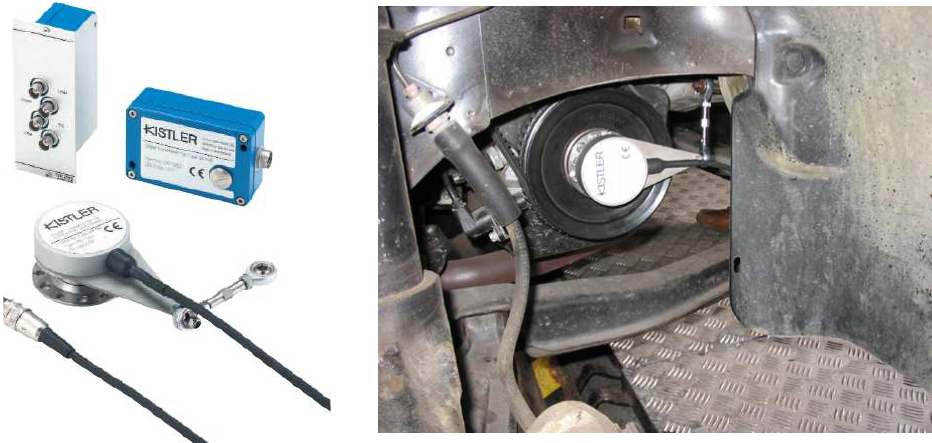
Figure 4. Crankshaft position sensor